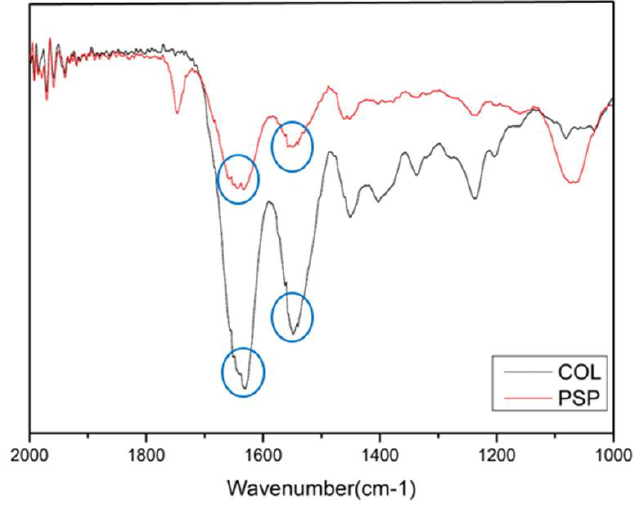
Figure 2. Fourier-transform infrared spectroscopy (FT-IR) spectra of the PSP and collagen type Ⅰ .